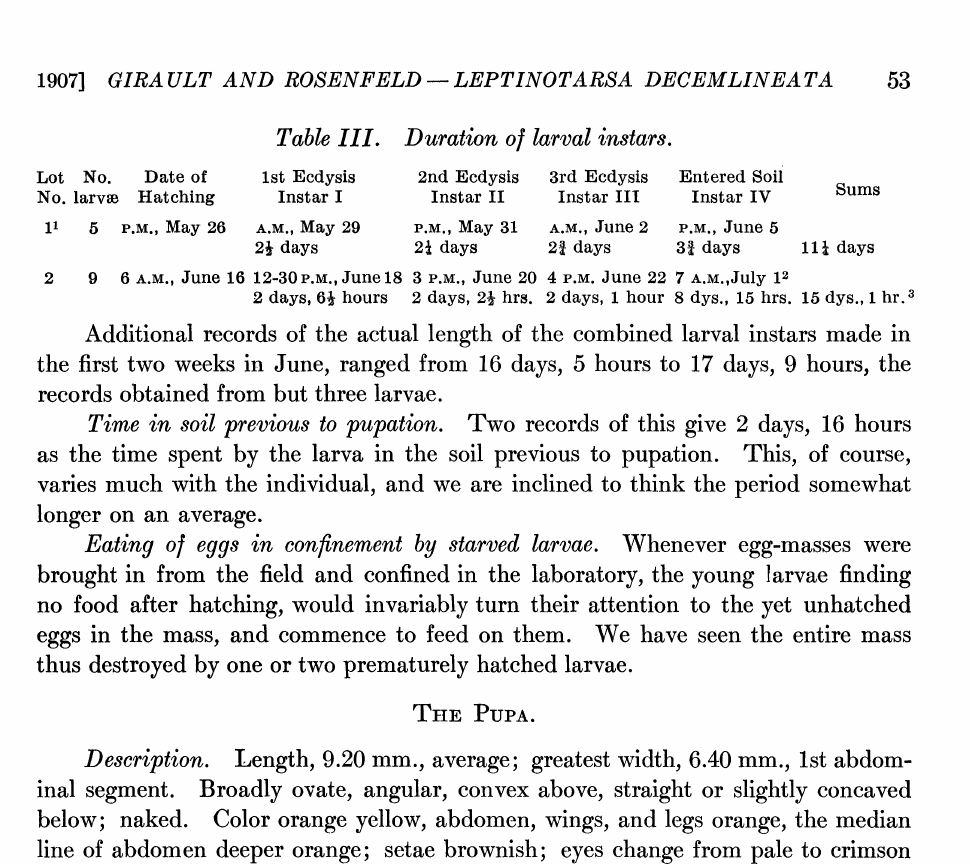
Table III. Duration o] larval